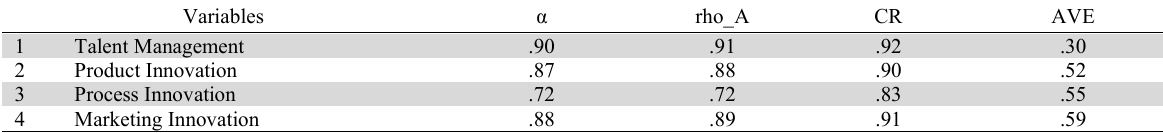
Reliability, convergent and divergent validity of research instruments Variables